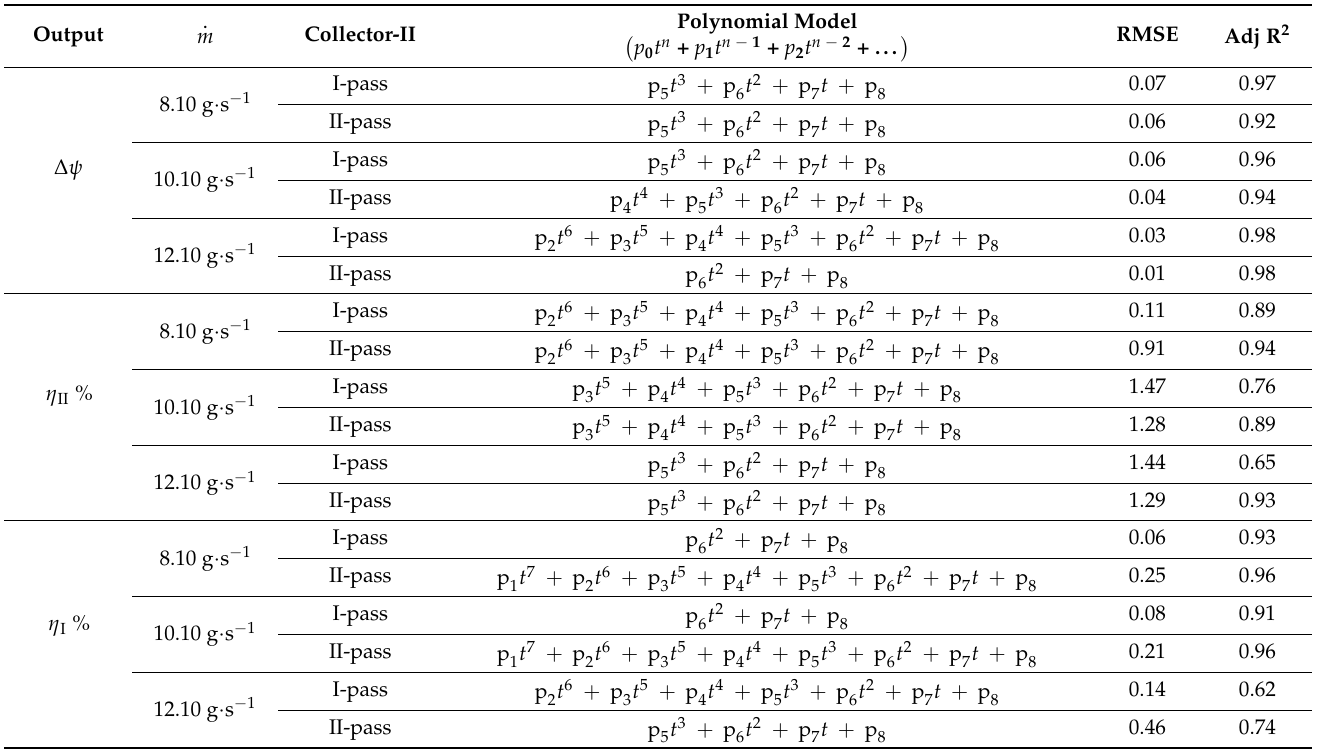
Table 3. The mathematical relation of ∆ ψ and η II with time, t , and the inlet temperature of the air, respectively, for